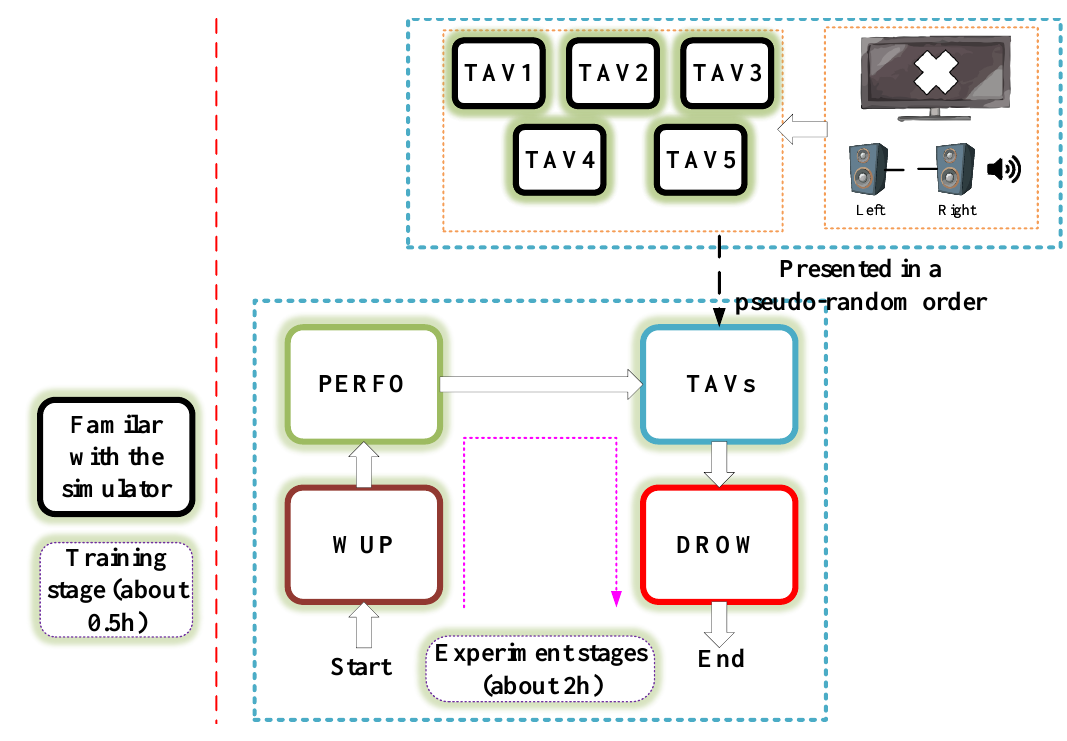
Figure 4. The experimental